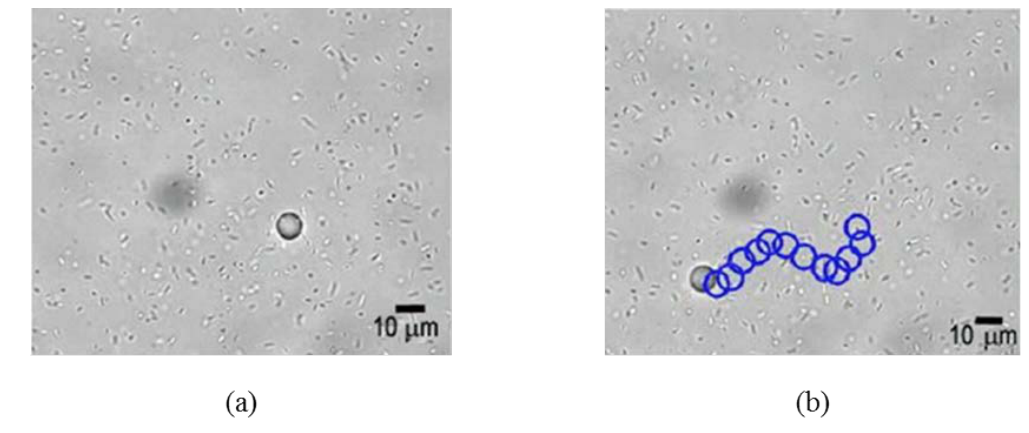
Figure 6. Phase-contrast optical image for the motion of a 10-μm diameter polystyrene bead propelled by S. marcescens bacteria at ( a ) t = 0 s and ( b ) t = 6 s